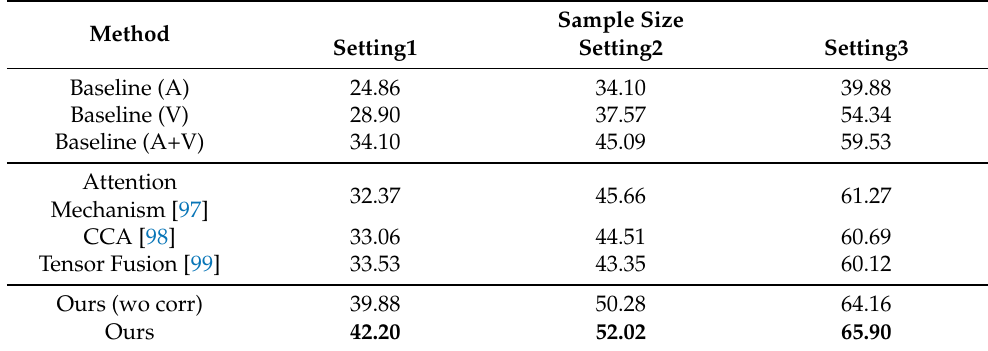
Table 2. Classification accuracy (%) of different methods on the RAVDESS dataset. Best results are shown in bold.